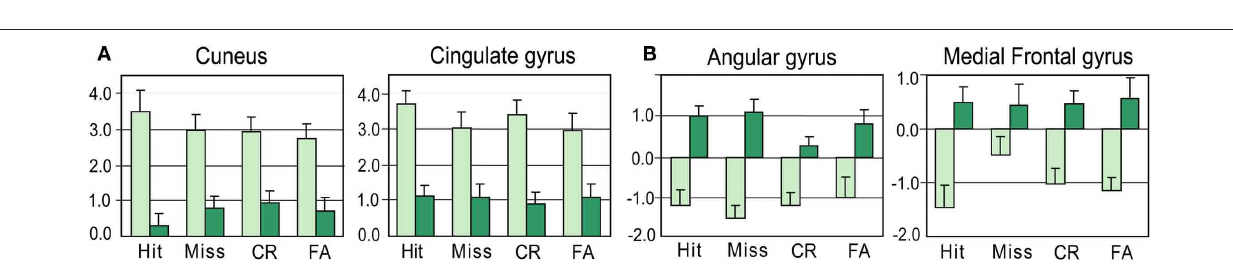
FIguRe 6 | Levels of activation for Hits, Misses, CR, and FA in young and elderly. (A) In the cuneus (11 − 87 4) and the cingulate gyrus (4 − 30 28). (B) In the angular ( − 46 − 61 36) and middle frontal ( − 34 30 44) gyri. Vertical bars, standard errors of the